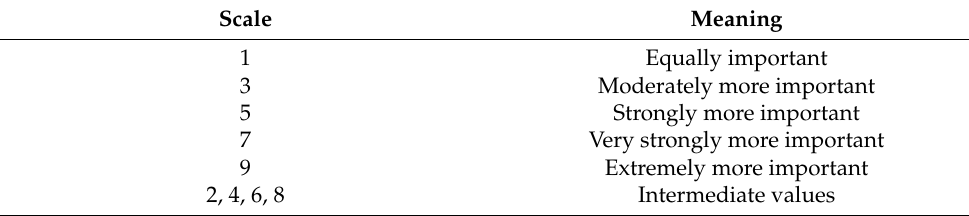
Table 3. KScale and significance of judgment